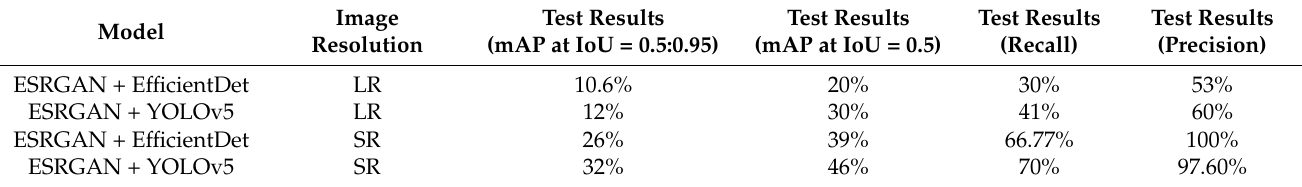
Table 1. Detection on super-resolution images and low-resolution images for both models. The AP (average precision) values are calculated using 10 different IoUs from 0.5 to 0.95 with 0.05 step